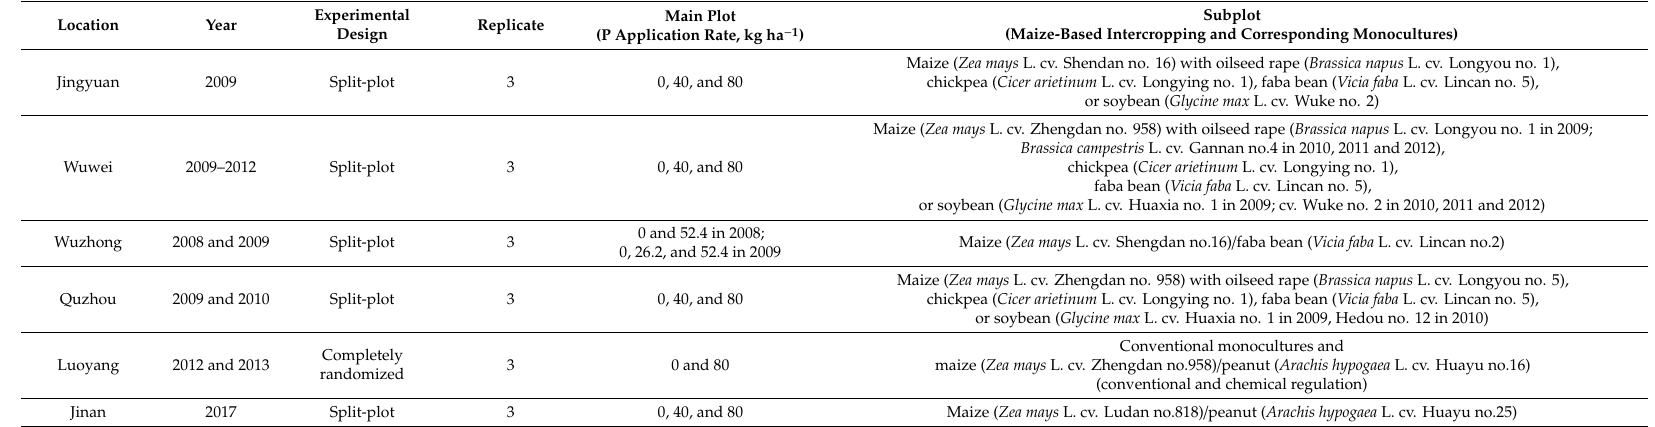
Table 3. Detailed study years and experimental design including di ff erent P application treatments, cropping systems, and crop cultivars used in di ff erent experimental locations.